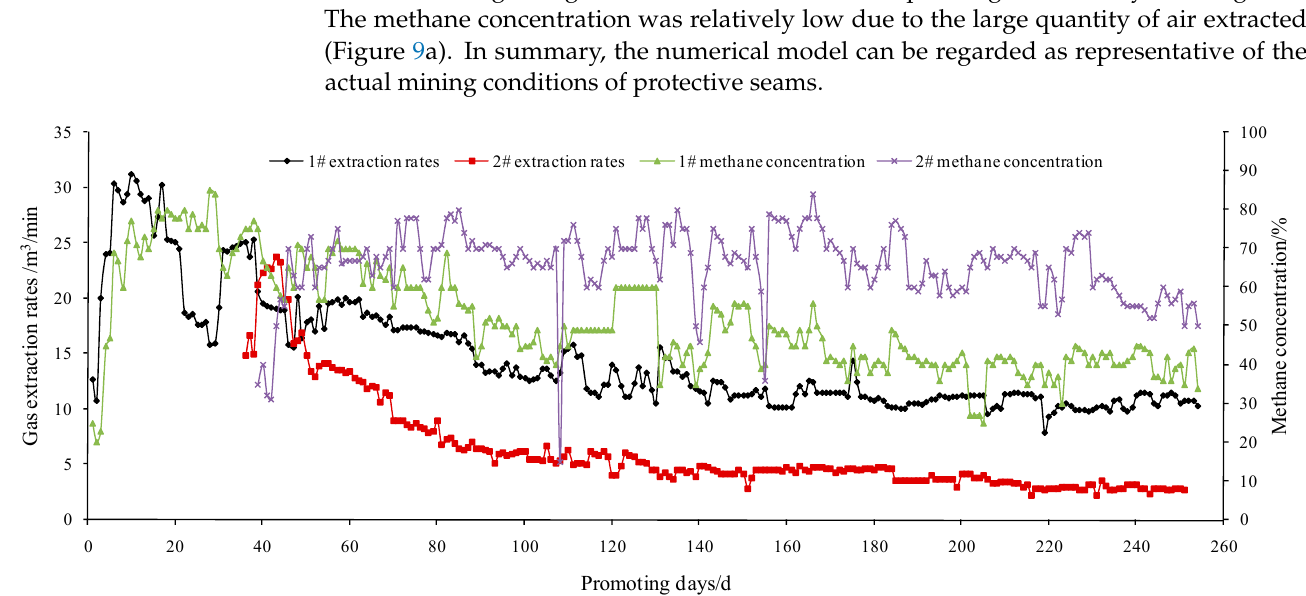
Figure 12. Gas extraction data of surface gas venthole.